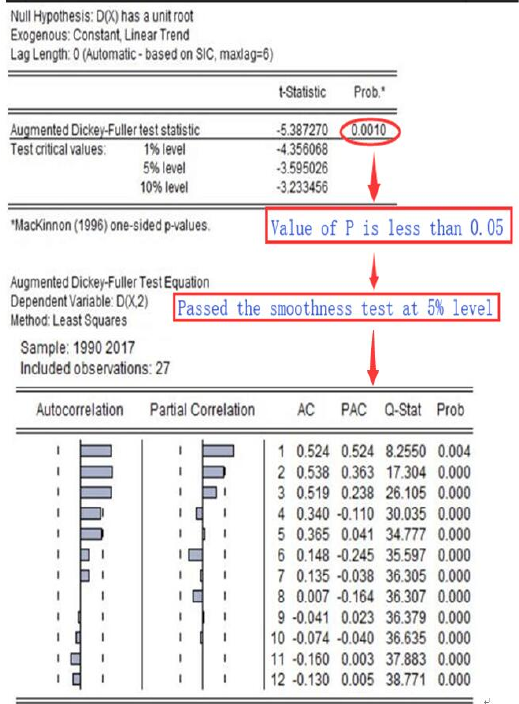
Figure 8. Stationary test result and Autocorrelation (partial autocorrelation) coe ffi cient map of ARIMA developed using Eviews 7.2.